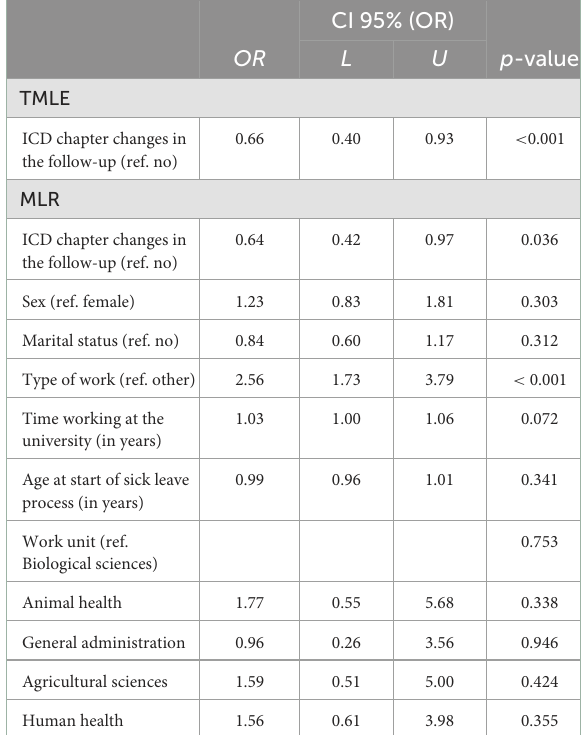
TABLE 3 Predictive models for the diagnosis of diseases included in chapter V of ICD-10 and returning to work with